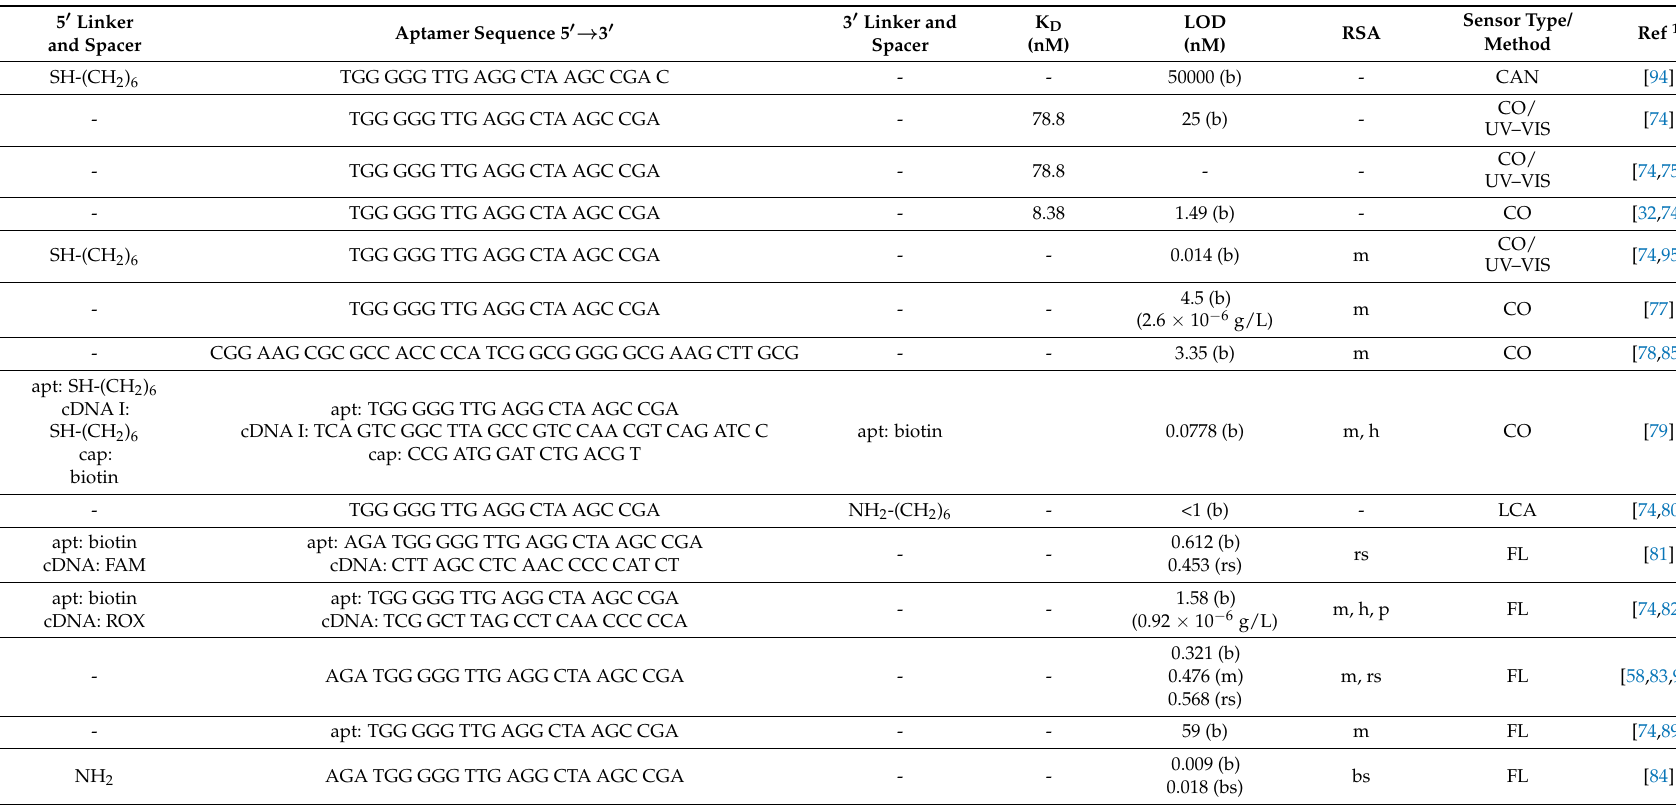
Table 4. Aptamer sequence, dissociation constant (K D ), limit of detection (LOD), real sample analysis (RSA), and realized sensor type and measuring method for kanamycin, mentioned in the corresponding references (Ref). apt = aptamer, AEC = amperometric electrochemical, b = buffer, bs = blood serum, c = chicken, CA = chronoamperometry, CAN = cantilever, cap = capture probe, cDNA = complementary DNA, CO = colorimetric, cy = cyanine dye, DPV = differential pulse voltammetry, ECL = electrochemiluminescent, EIS = electrochemical impedance spectrometry, f = fish, FAM = fluorescein amidite, FL = fluorometric, hs = human serum, IEC = impedimetric electrochemical, LCA = liquid crystal assay, lw = lake water, m = milk, MB = methylene blue, p = pork, PEC = photoelectrochemical, rs = rat serum, ROX = 6-carboxyl-x-rhodamine, SWV = square wave voltammetry, and ww = waste